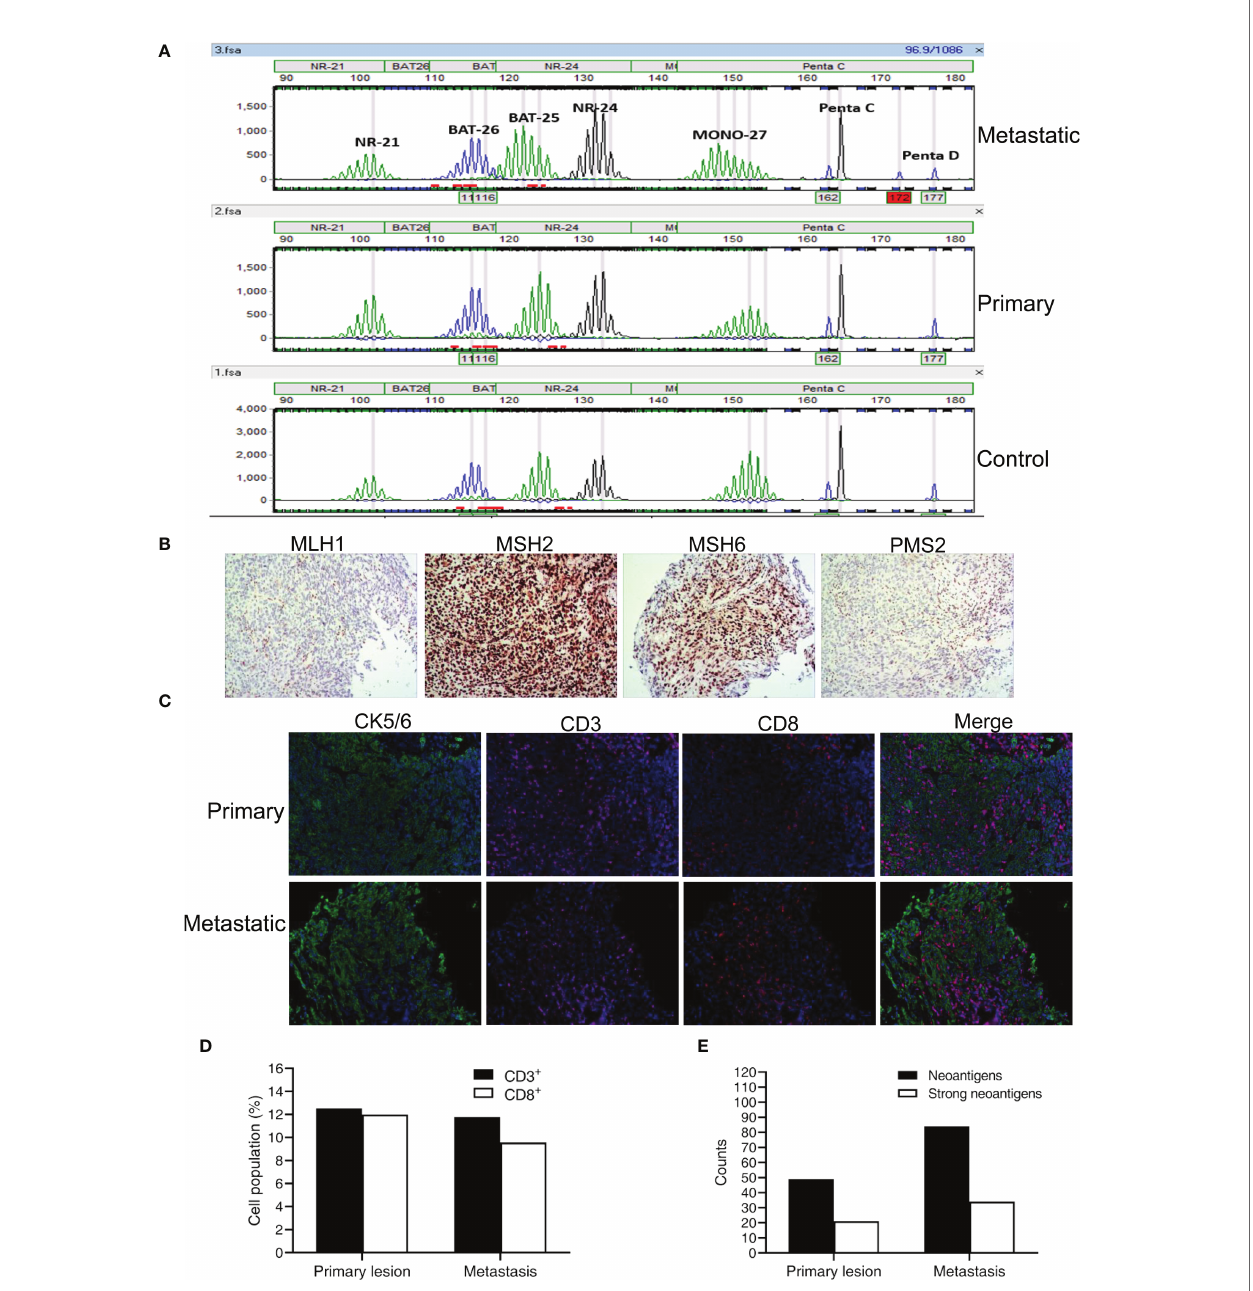
FIGURE 2 | MSI status, MMR results, and immune phenotypes together with neoantigens in primary and metastatic lesions of this patient. (A) Detection results of fi ve microsatellite sites by the MSI analysis system (Promega). (B) MMR results of MLH1, MSH2, MSH6, and PMS2 in metastasis. (C) Representative images of CK5/ 6 (cytokeratin 5/6), CD3, and CD8 shown by mIHC in primary and metastatic lesions. Nuclei (blue) were counterstained by DAPI. Magni fi cation, ×200. (D) Quanti fi cation results of mIHC from 15 random vision fi elds. (E) The number of predicted neoantigens in primary and metastatic